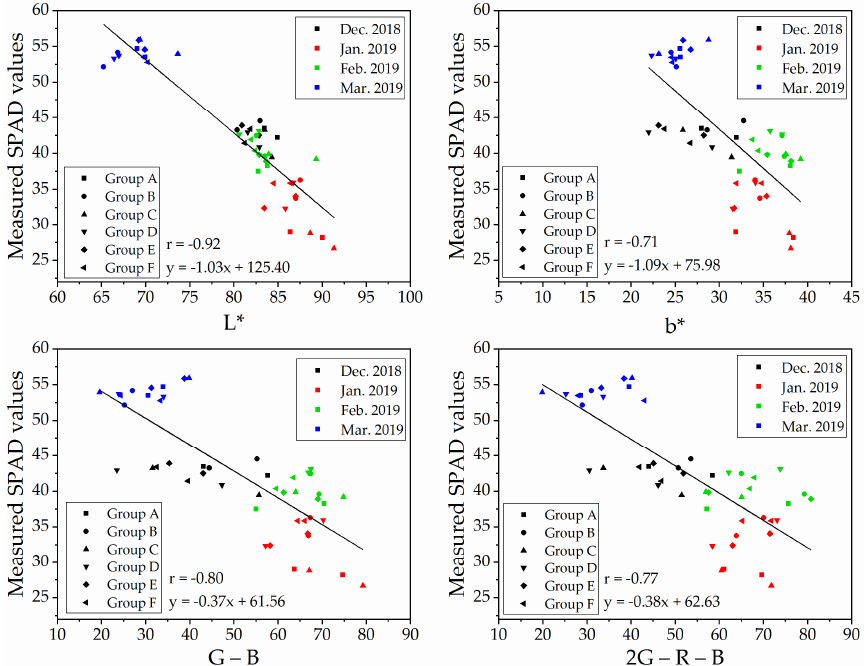
Figure 7. Relationships between measured SPAD values and UAV images (with vegetation extraction and naked barley ear masked)-derived vegetation indices at the flight height of 6.0 m (n = 48).